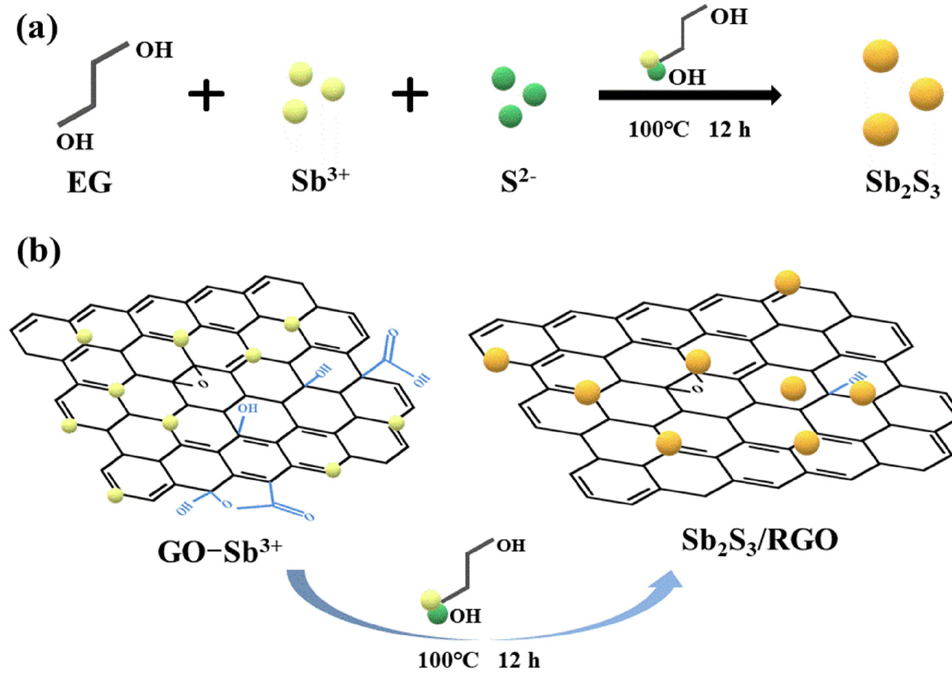
Figure 1. Schematic illustration of the formation of Sb 2 S 3 NPs ( a ) and Sb 2 S 3 /RGO ( b ).